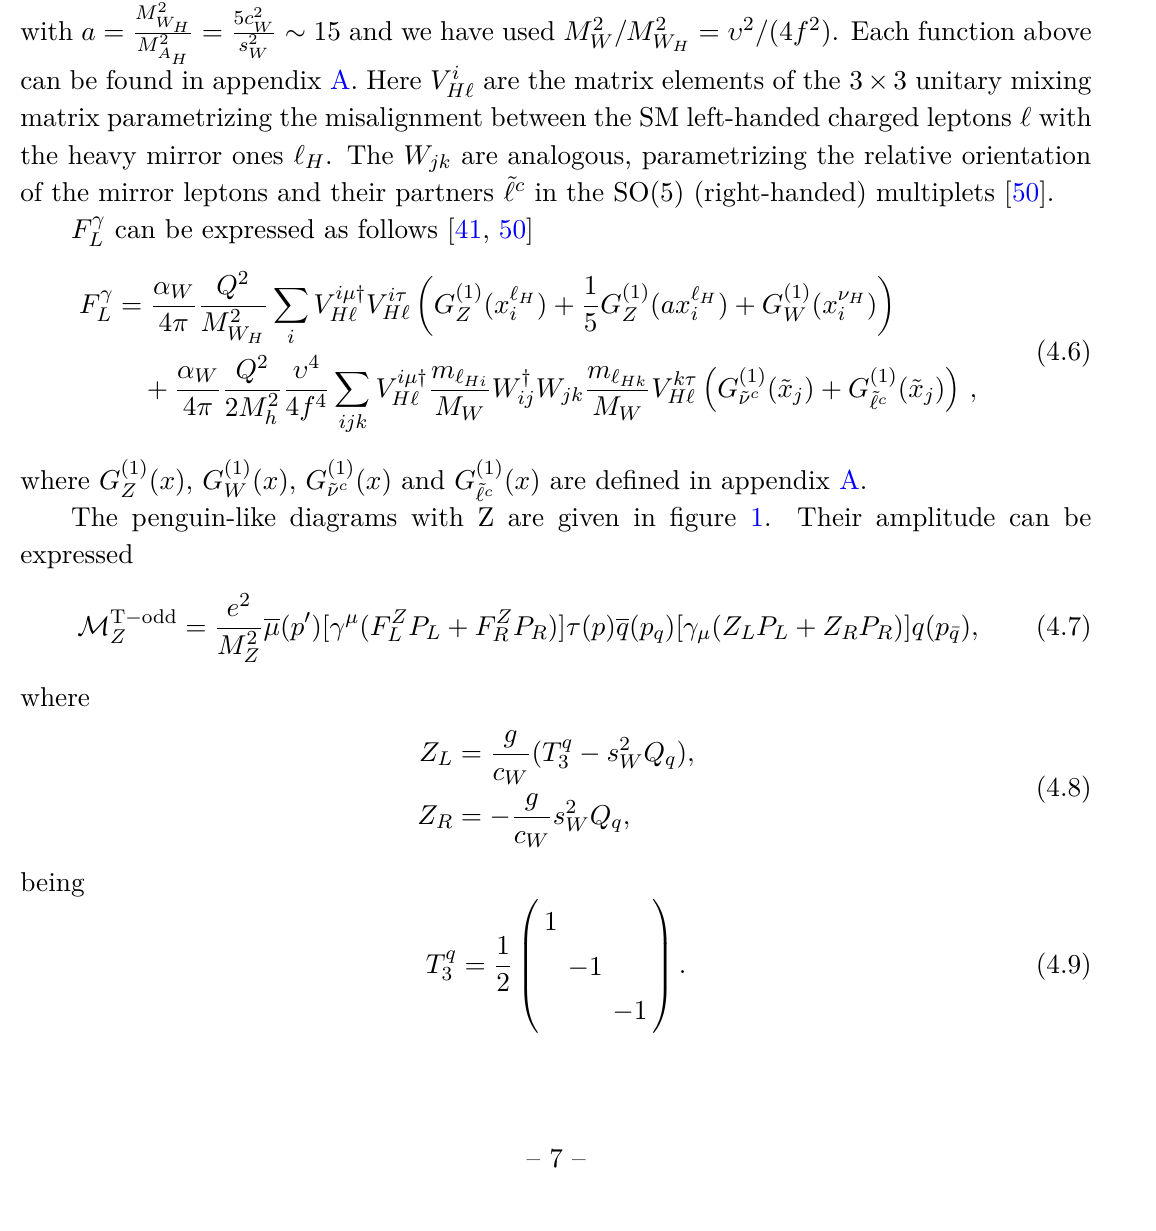
= υ 2 / (4 f 2 ) . Each function /M 2 W W H